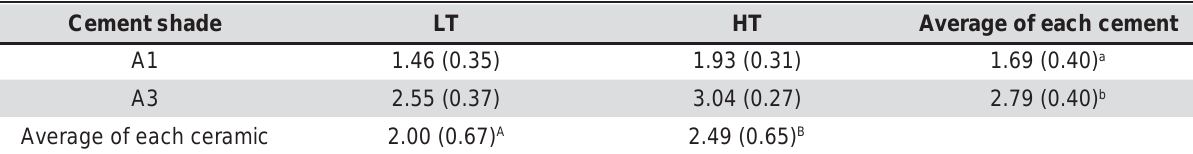
Table 1- (cid:3)(cid:38)(cid:82)(cid:79)(cid:82)(cid:85)(cid:3)(cid:71)(cid:76)(cid:73)(cid:73)(cid:72)(cid:85)(cid:72)(cid:81)(cid:70)(cid:72)(cid:3)(cid:11)(cid:507)(cid:40)(cid:12)(cid:3)(cid:76)(cid:81)(cid:3)(cid:47)(cid:55)(cid:3)(cid:68)(cid:81)(cid:71)(cid:3)(cid:43)(cid:55)(cid:3)(cid:70)(cid:72)(cid:85)(cid:68)(cid:80)(cid:76)(cid:70)(cid:86)(cid:3)(cid:68)(cid:73)(cid:87)(cid:72)(cid:85)(cid:3)(cid:70)(cid:72)(cid:80)(cid:72)(cid:81)(cid:87)(cid:3)(cid:76)(cid:81)(cid:86)(cid:72)(cid:85)(cid:87)(cid:76)(cid:82)(cid:81)(cid:3)(cid:11)(cid:86)(cid:87)(cid:68)(cid:81)(cid:71)(cid:68)(cid:85)(cid:71)(cid:3)(cid:71)(cid:72)(cid:89)(cid:76)(cid:68)(cid:87)(cid:76)(cid:82)(cid:81)(cid:86)(cid:12)(cid:15)(cid:3)(cid:87)(cid:75)(cid:72)(cid:3)(cid:80)(cid:72)(cid:68)(cid:81)(cid:86)(cid:3)(cid:73)(cid:82)(cid:79)(cid:79)(cid:82)(cid:90)(cid:72)(cid:71)(cid:3) (cid:69)(cid:92)(cid:3)(cid:71)(cid:76)(cid:73)(cid:73)(cid:72)(cid:85)(cid:72)(cid:81)(cid:87)(cid:3)(cid:79)(cid:72)(cid:87)(cid:87)(cid:72)(cid:85)(cid:86)(cid:3)(cid:62)(cid:88)(cid:83)(cid:83)(cid:72)(cid:85)(cid:3)(cid:70)(cid:68)(cid:86)(cid:72)(cid:3)(cid:79)(cid:72)(cid:87)(cid:87)(cid:72)(cid:85)(cid:86)(cid:3)(cid:90)(cid:76)(cid:87)(cid:75)(cid:76)(cid:81)(cid:3)(cid:87)(cid:75)(cid:72)(cid:3)(cid:70)(cid:82)(cid:79)(cid:88)(cid:80)(cid:81)(cid:86)(cid:3)(cid:11)(cid:70)(cid:72)(cid:85)(cid:68)(cid:80)(cid:76)(cid:70)(cid:12)(cid:3)(cid:68)(cid:81)(cid:71)(cid:3)(cid:79)(cid:82)(cid:90)(cid:72)(cid:85)(cid:3)(cid:70)(cid:68)(cid:86)(cid:72)(cid:3)(cid:79)(cid:72)(cid:87)(cid:87)(cid:72)(cid:85)(cid:86)(cid:3)(cid:90)(cid:76)(cid:87)(cid:75)(cid:76)(cid:81)(cid:3)(cid:87)(cid:75)(cid:72)(cid:3)(cid:85)(cid:82)(cid:90)(cid:86)(cid:3)(cid:11)(cid:70)(cid:72)(cid:80)(cid:72)(cid:81)(cid:87)(cid:12)(cid:64)(cid:3)(cid:68)(cid:85)(cid:72)(cid:3) (cid:86)(cid:76)(cid:74)(cid:81)(cid:76)(cid:191)(cid:70)(cid:68)(cid:81)(cid:87)(cid:79)(cid:92)(cid:3)(cid:71)(cid:76)(cid:73)(cid:73)(cid:72)(cid:85)(cid:72)(cid:81)(cid:87)(cid:3)(cid:11)(cid:83)(cid:31)(cid:19)(cid:17)(cid:19)(cid:24)(cid:12)